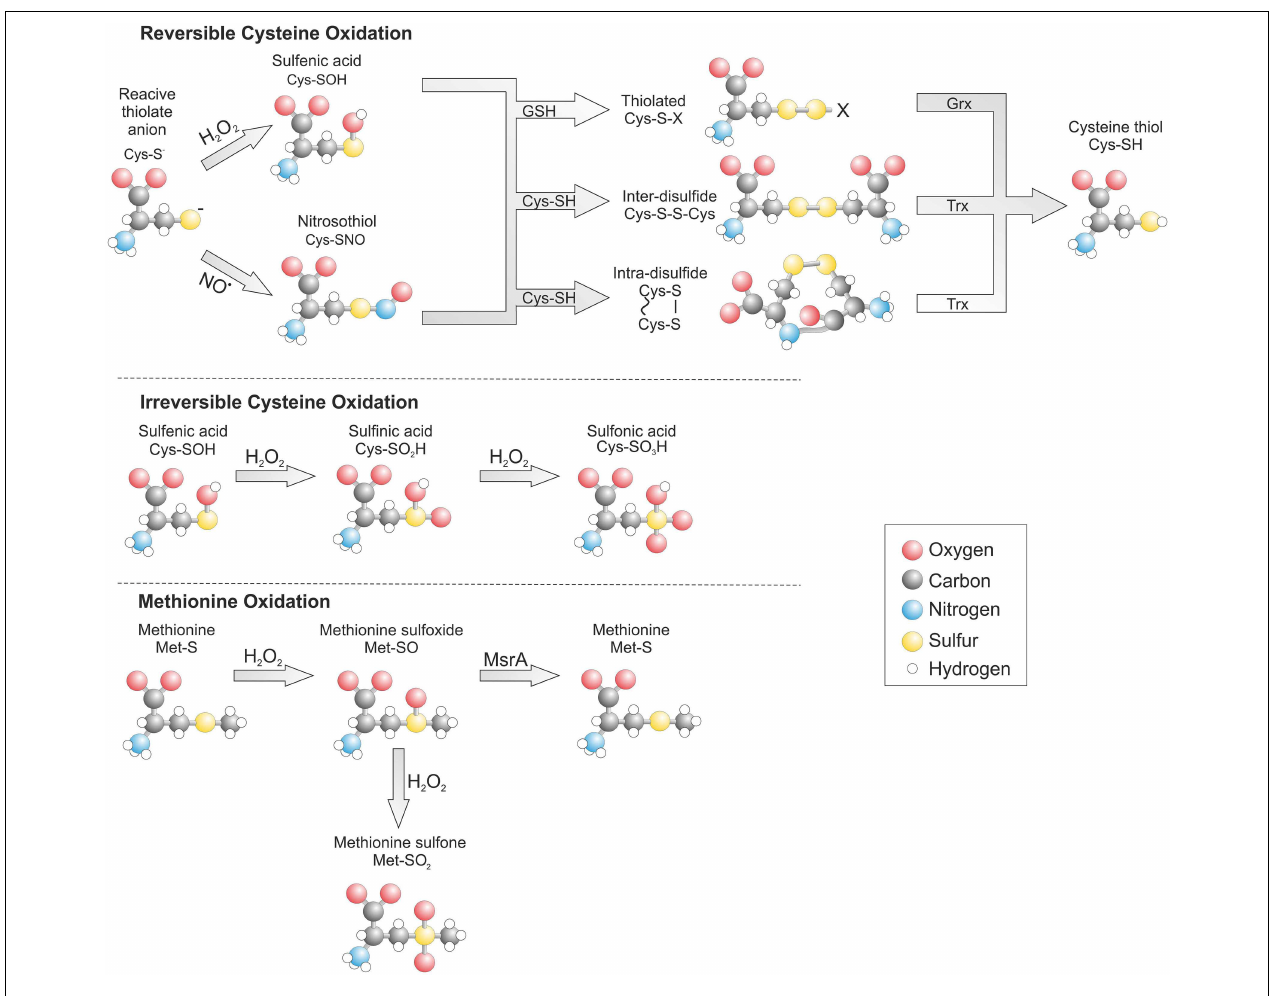
reduced by thioredoxin (Trx). Oxidation of a methionine to the sulfoxide form can be reduced by methionine sulfoxide reductase A